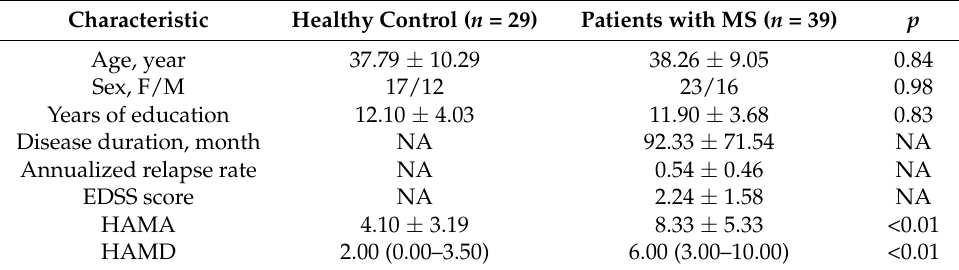
Table 5. Demographic and clinical characteristics in the MS group and healthy